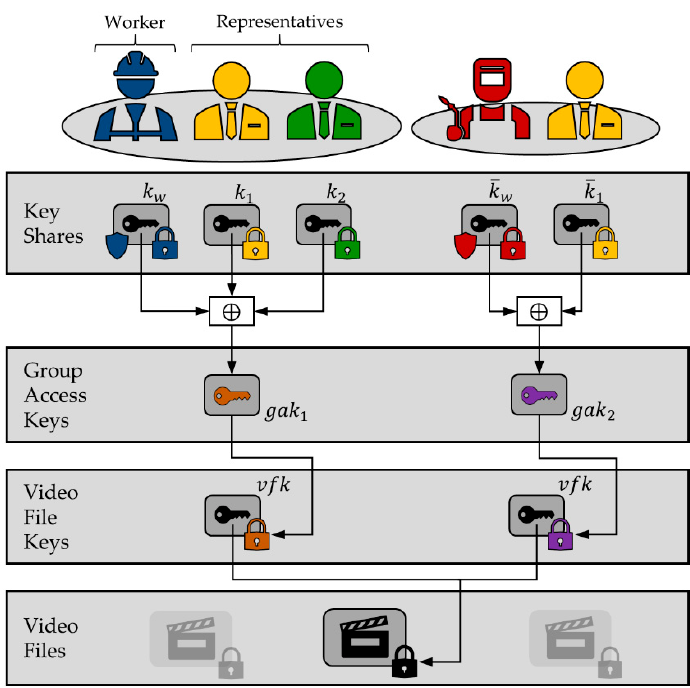
Figure 4. Encryption and key sharing architecture of 4Crypt.